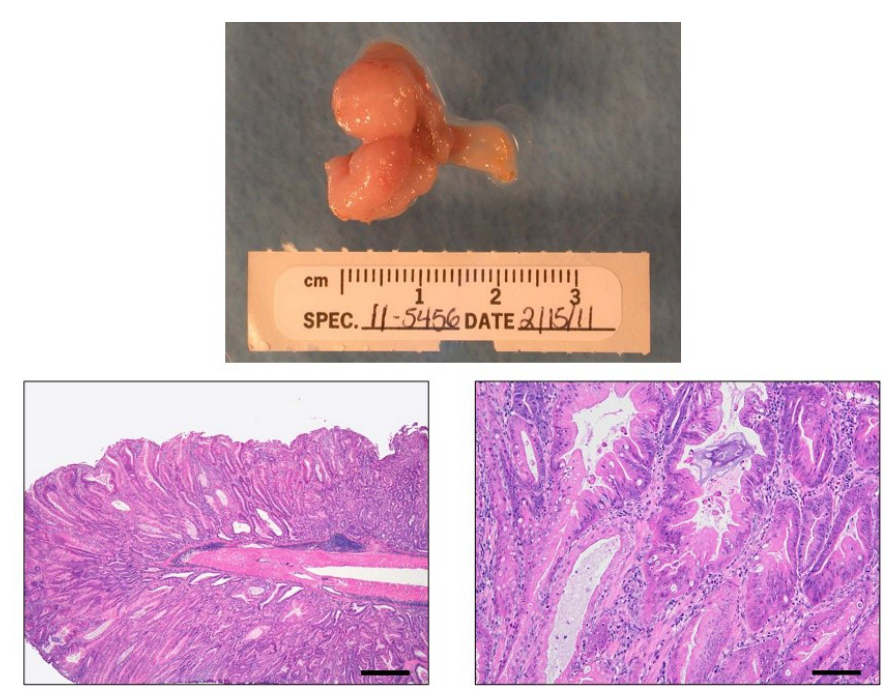
Figure 2. INS-GAS mouse tumor. Gross image: Stomach of a H. pylori -infected male INS-GAS mouse at 7 mpi showing coalescing diffuse tumors of the glandular stomach. Bottom panels: Low and high magnification H&E images of the stomach of an Hp -infected male INS-GAS mouse at 7 mpi showing diffuse high grade dysplastic/neoplastic